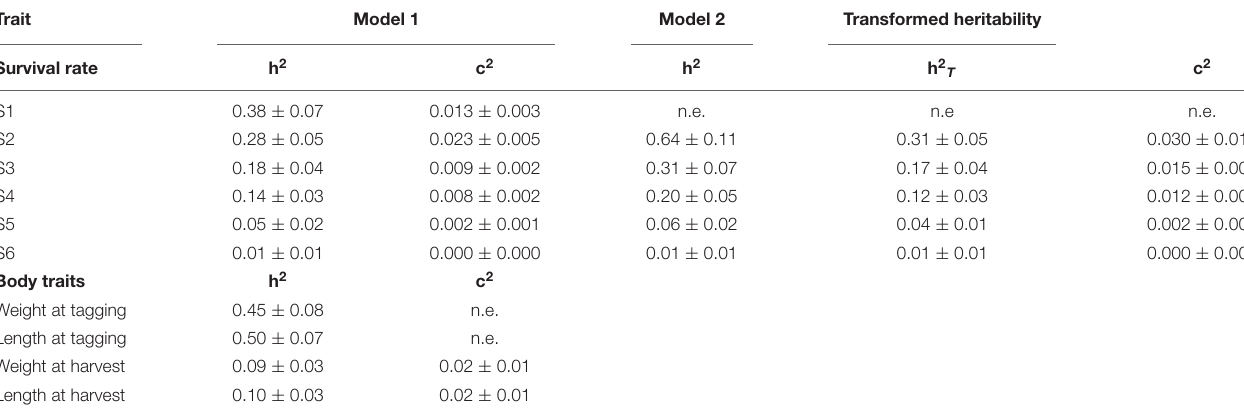
TABLE 3 | Heritability (h 2 ± s.e.) for WSSV resistance, and h 2 and common full-sib effects (c 2 ± s.e.) for body traits. Trait Model 1 Model 2 Survival rate